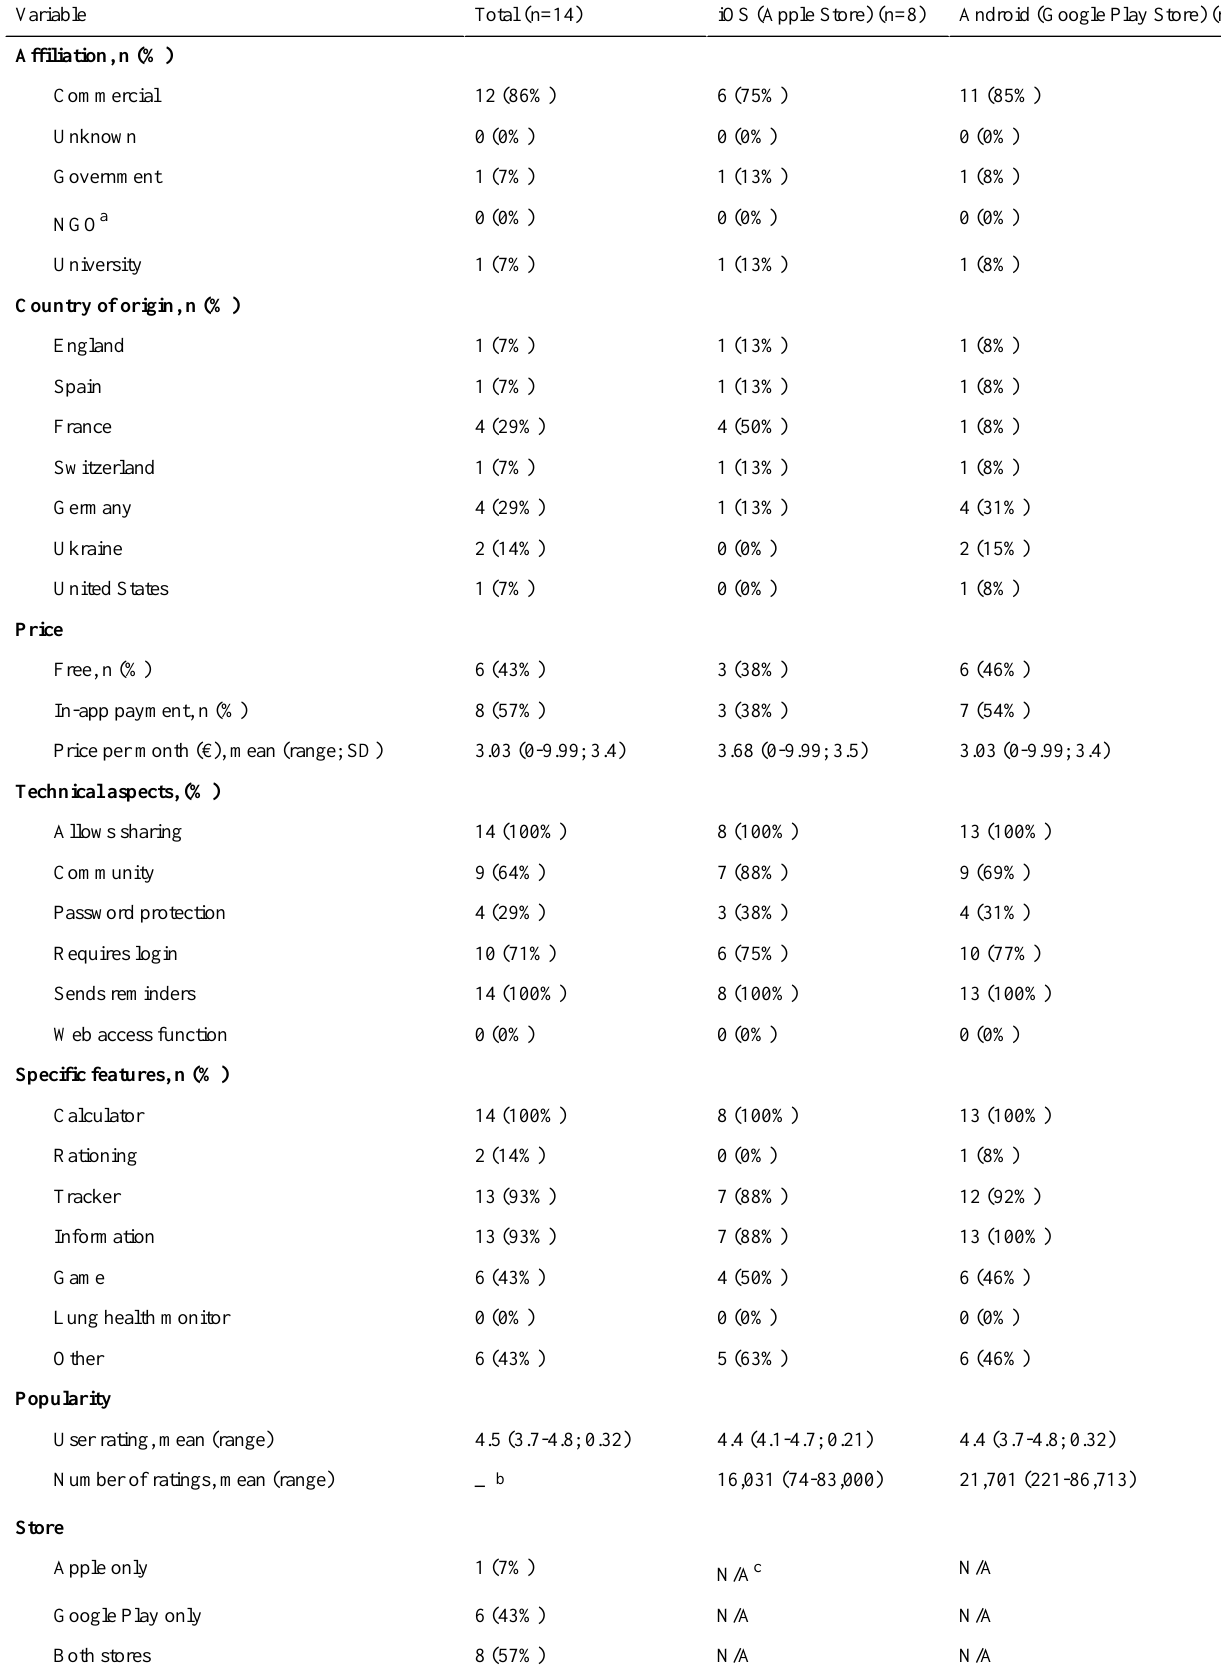
Table 1. General information of the rated apps from the French Apple Store and Google Play Store